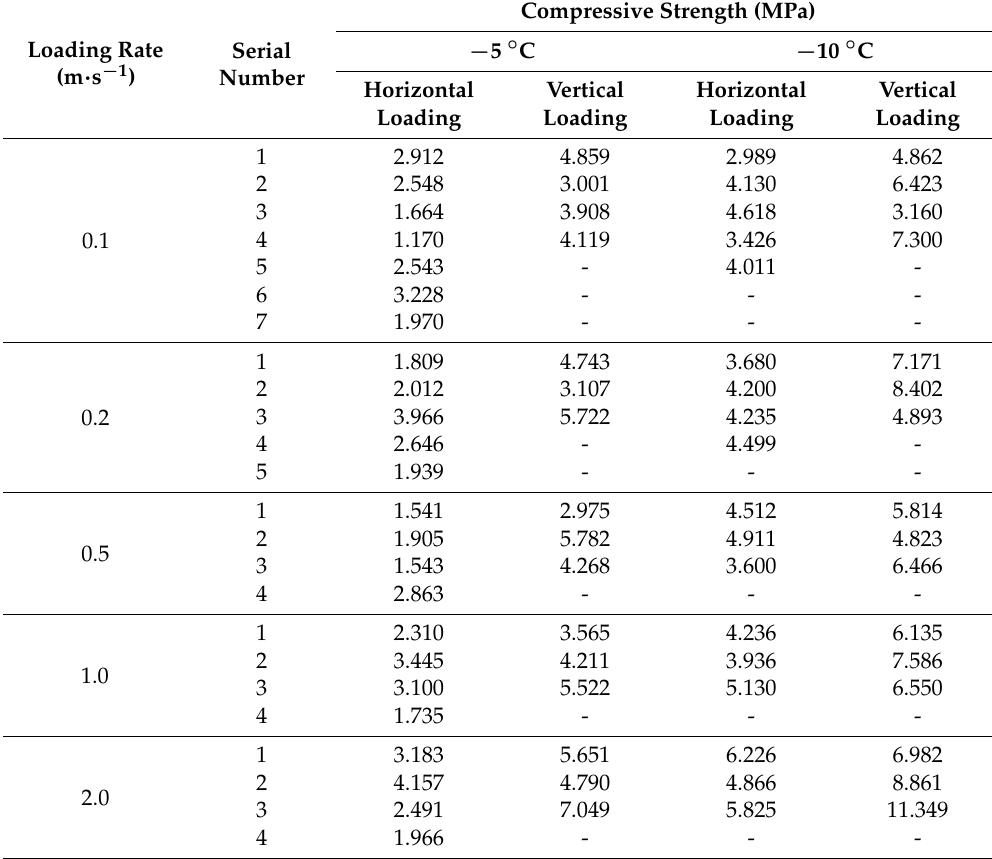
Table 3. Uniaxial compressive strength results of soft ice with two temperatures, two loading directions, and five loading